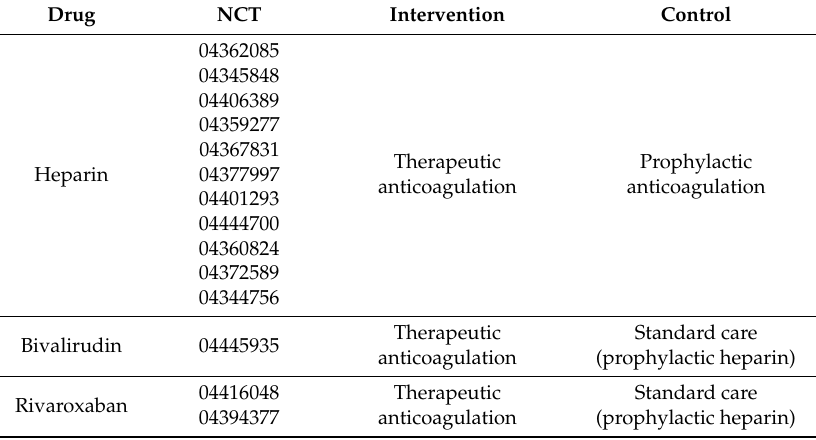
Table 1. Most relevant current clinical trials exploring the e ff ectiveness of anticoagulation (source: